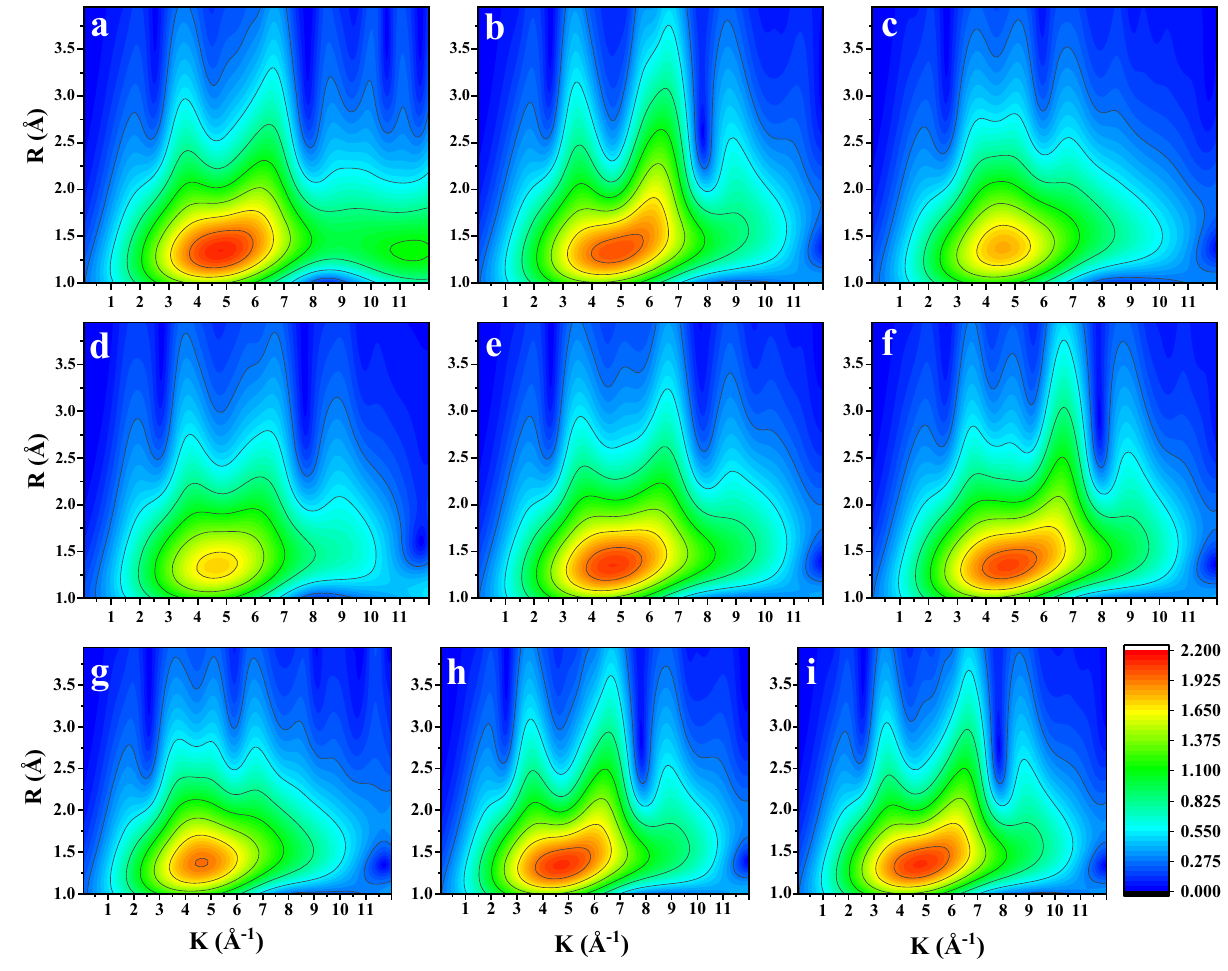
Fig. 3 | WT plots for EXAFS spectra of Cu-SSZ-13 treated under different con- ditions at 200°C. a Cu-SSZ-13 pretreated in O 2 /He. b NO adsorption. c NH 3 adsorption. d NO+NH 3 adsorption. e NO+NH 3